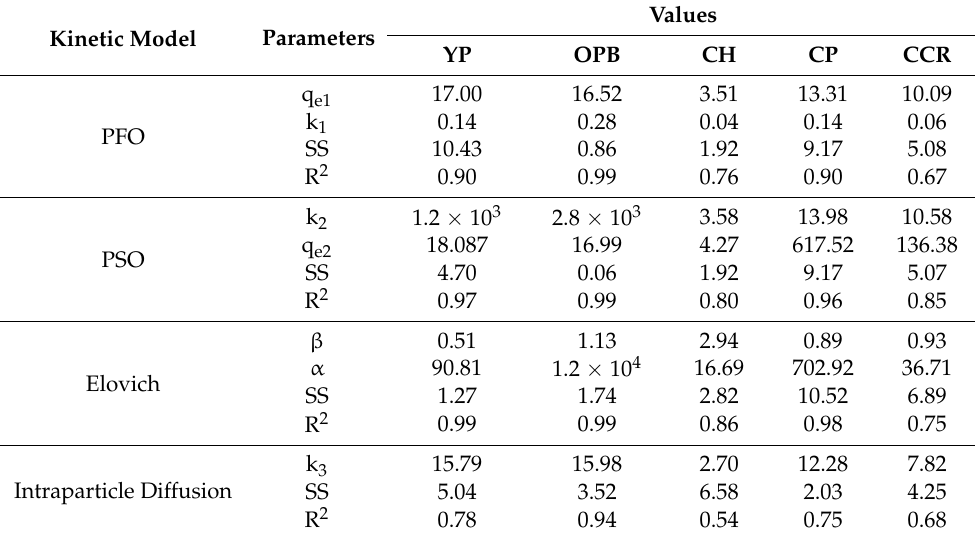
Table 4. Adjustment parameters of the Pseudo-first order, Pseudo-second order, Elovich and Intra- particle difussion’s models of Cd 2+ adsorption onto YP, OPB, CH, CP and